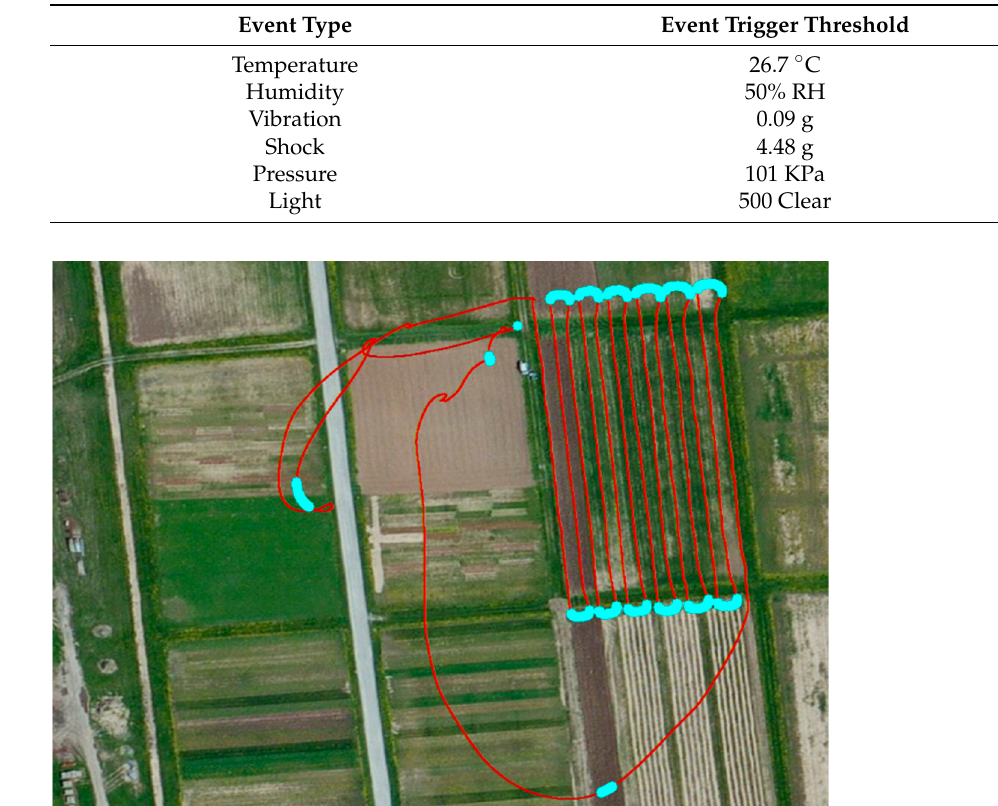
Figure 2. The DJI Matrice 600 Pro and The DJI Matrice 100 and the data logger locations. Table 2. Data logger recording parameters. Table 2. Data logger recording parameters.